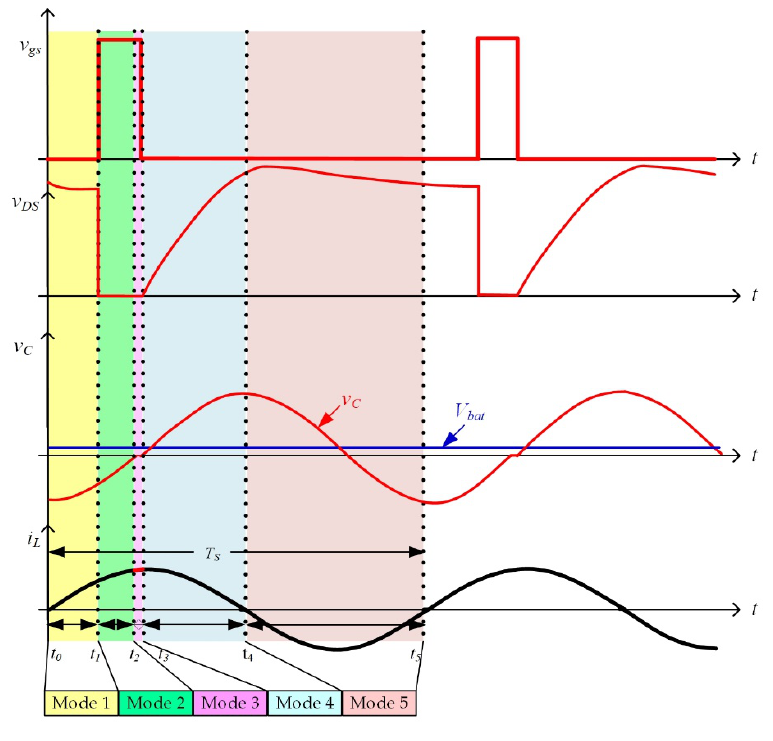
Figure 3. The key waveforms of the sinusoidal load in a switching period.